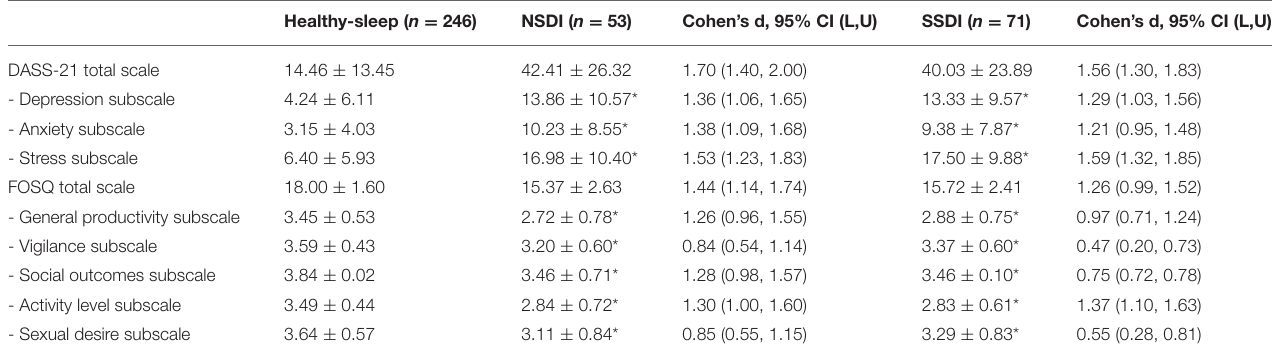
TABLE 4 | Means and standard deviations for self-reported mood and daytime function assessments (DASS-21 and FOSQ questionnaires) for the healthy sleepers, those with NSDI, and